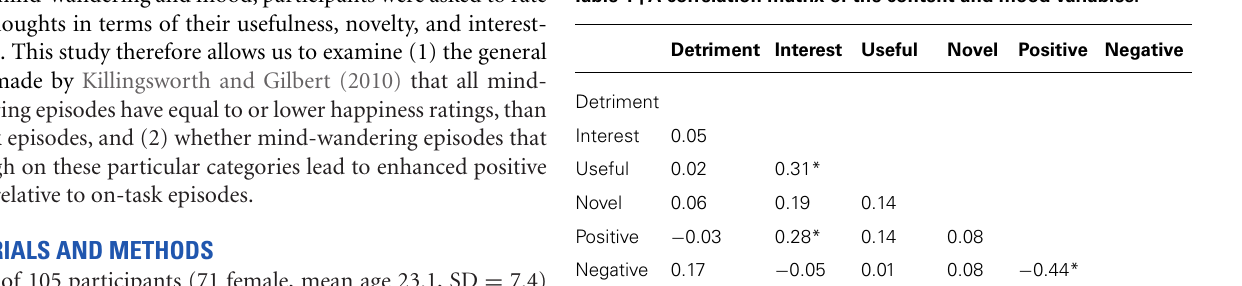
Table 1 |A correlation matrix of the content and mood